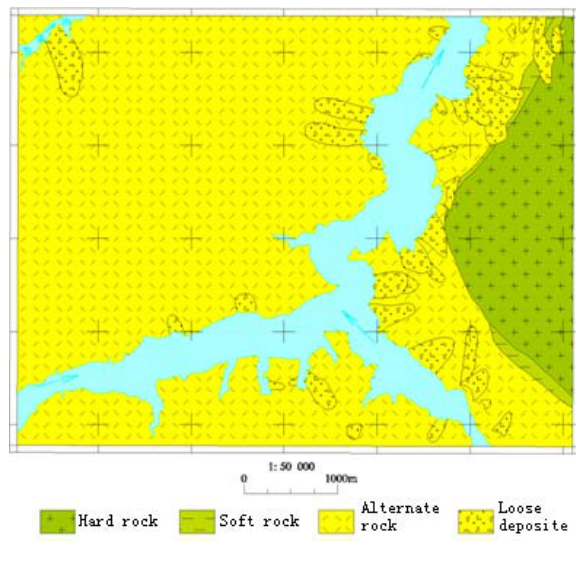
Figure 17. Distribution graph of engineering rock